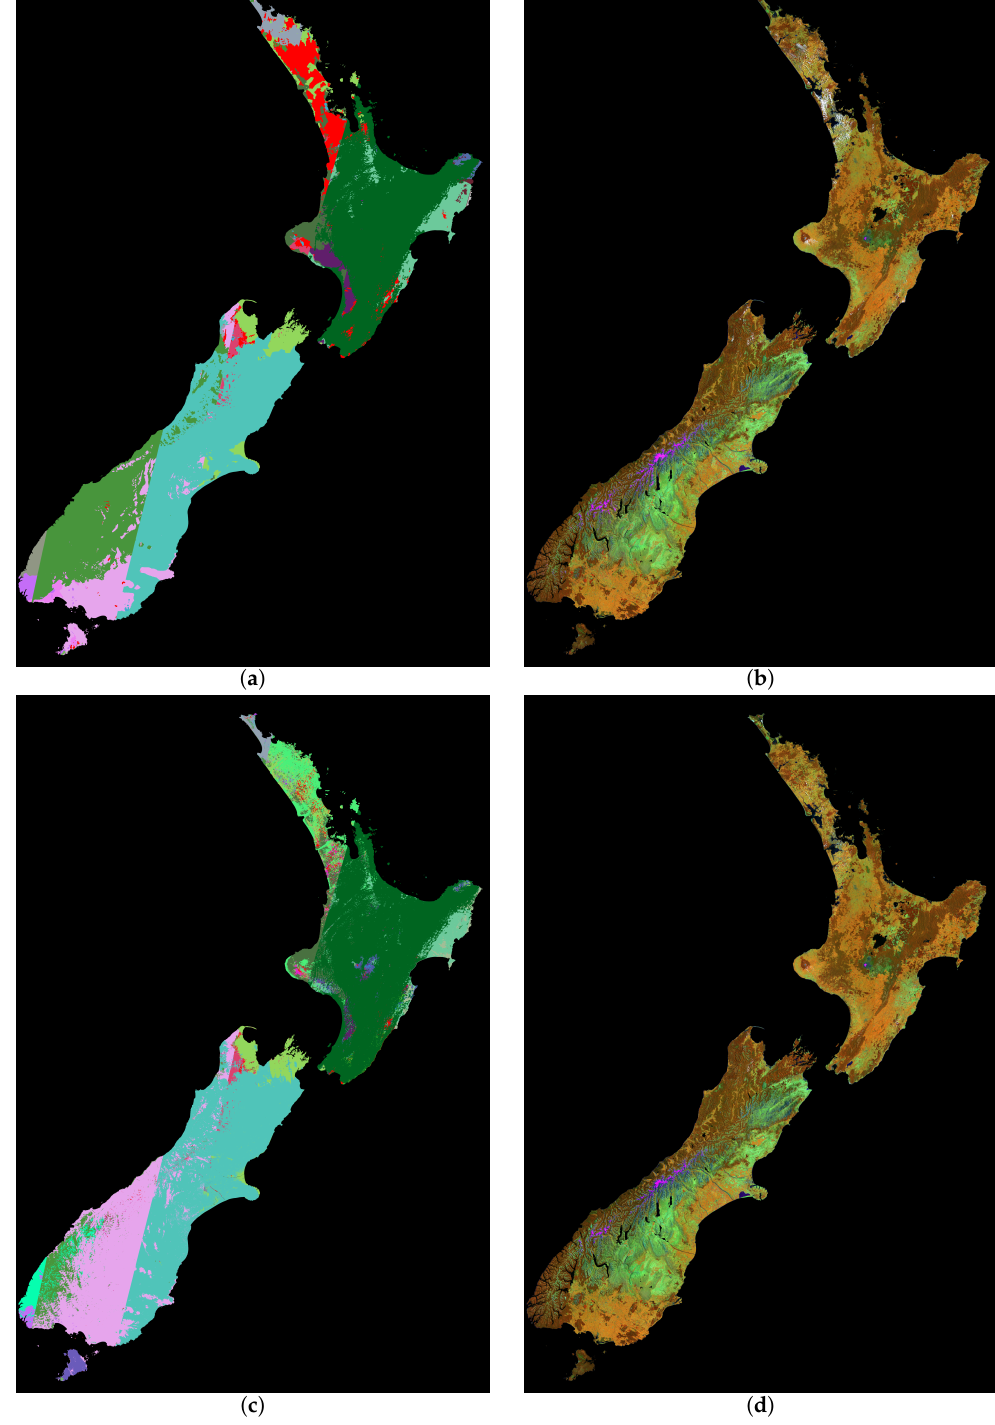
Figure 5. Comparison of 2015/16 summer mosaic of New Zealand. Panels ( a , b ) show the result for manual cloud/cloud-shadow detection. Panels ( c , d ) show the result for automated cloud/cloud-shadow detection. Panels ( a , c ) are control masks where the colours represent the image date used for the mosaic and red is remaining cloud. Overpasses can change priority between the mosaics produced by each approach as the automated mosaicking process calculates priority weighted by contributing cloud-free